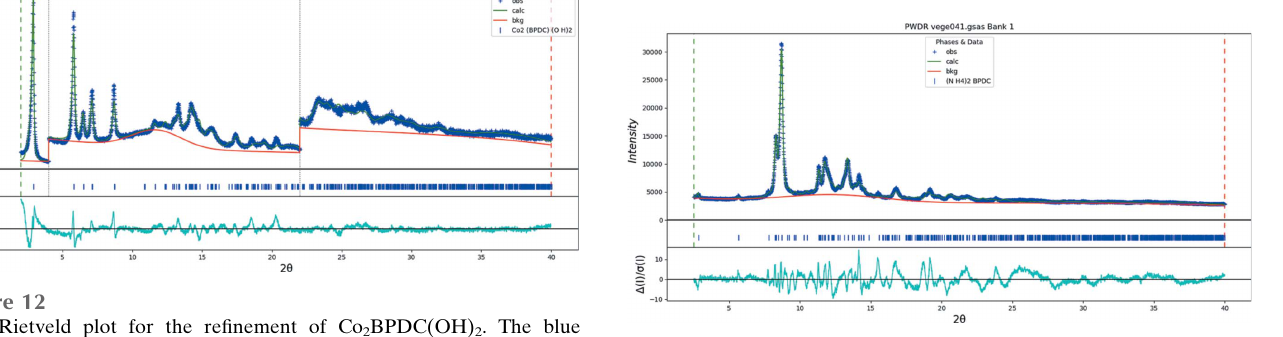
Figure 14 The Rietveld plot for the refinement of (NH 4 ) 2 BPDC(OH) 2 . The blue crosses represent the observed data points, and the green line is the calculated pattern. The cyan curve is the normalized error plot. The row of tick marks indicates the calculated reflection